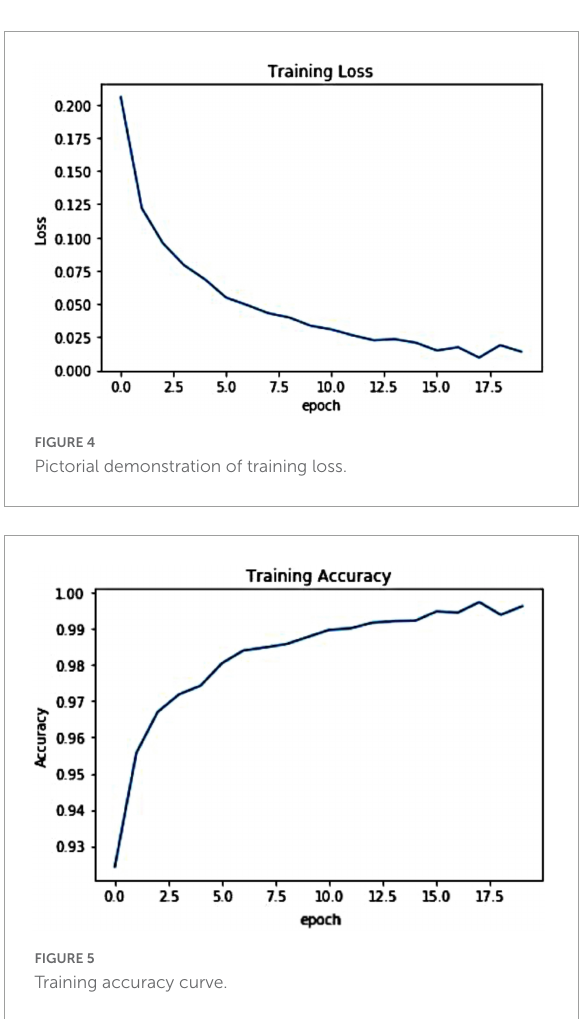
FIGURE5 Training accuracy